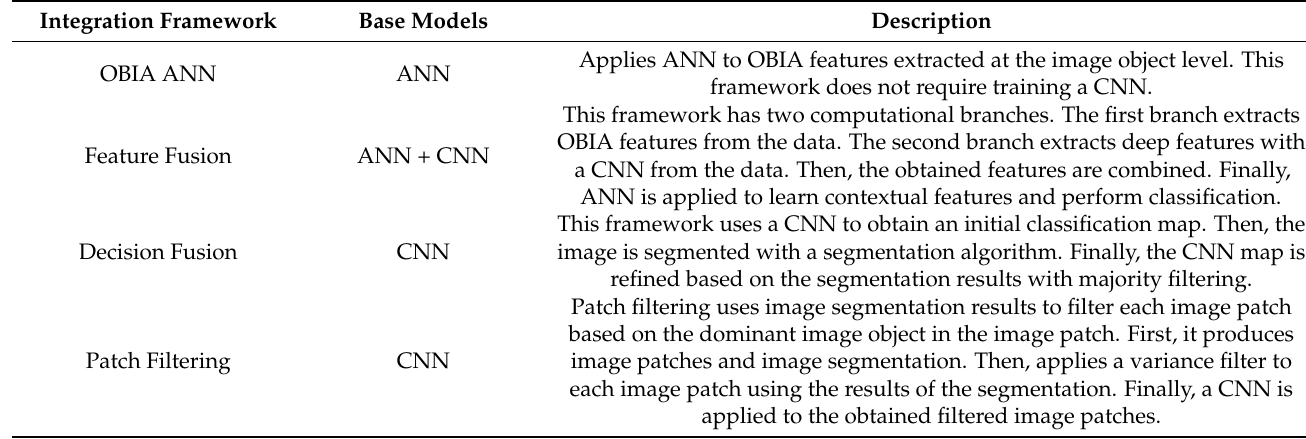
Figure 4. An example of the integration between OBIA and CNN for satellite image classification. Table 2. Description of the integration frameworks assessed in this